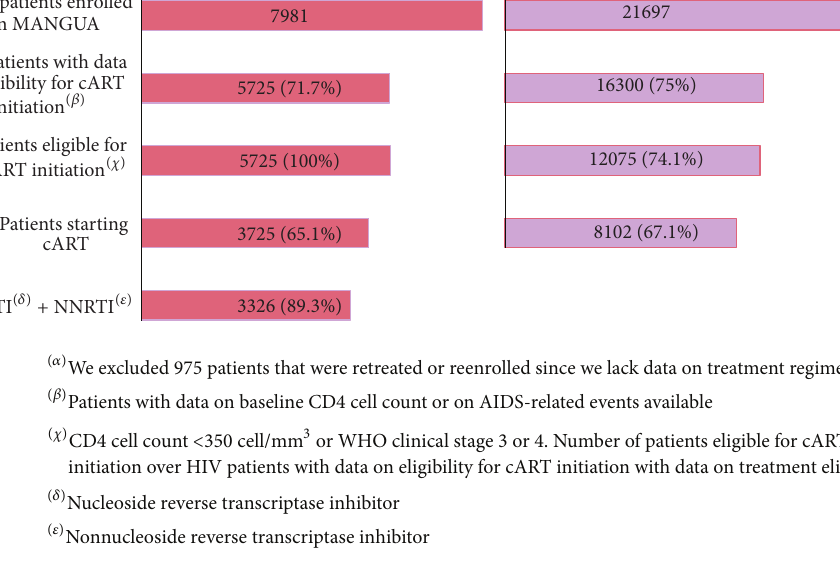
Figure 2: Spectrum of cART initiation in patients enrolled in MANGUA